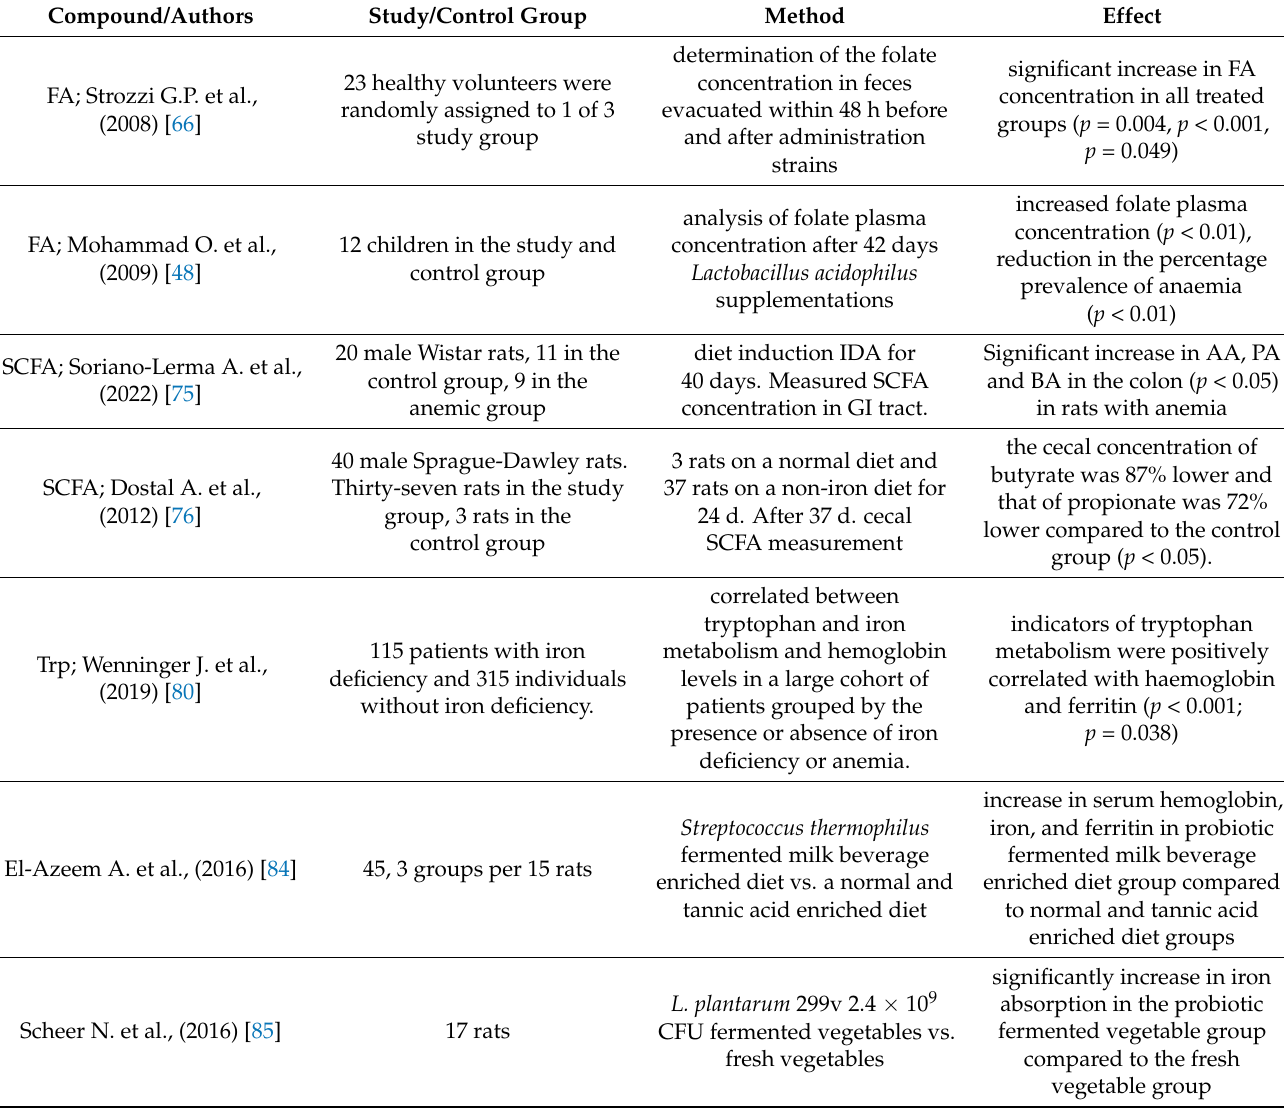
Table 4. Studies evaluating postbiotics in